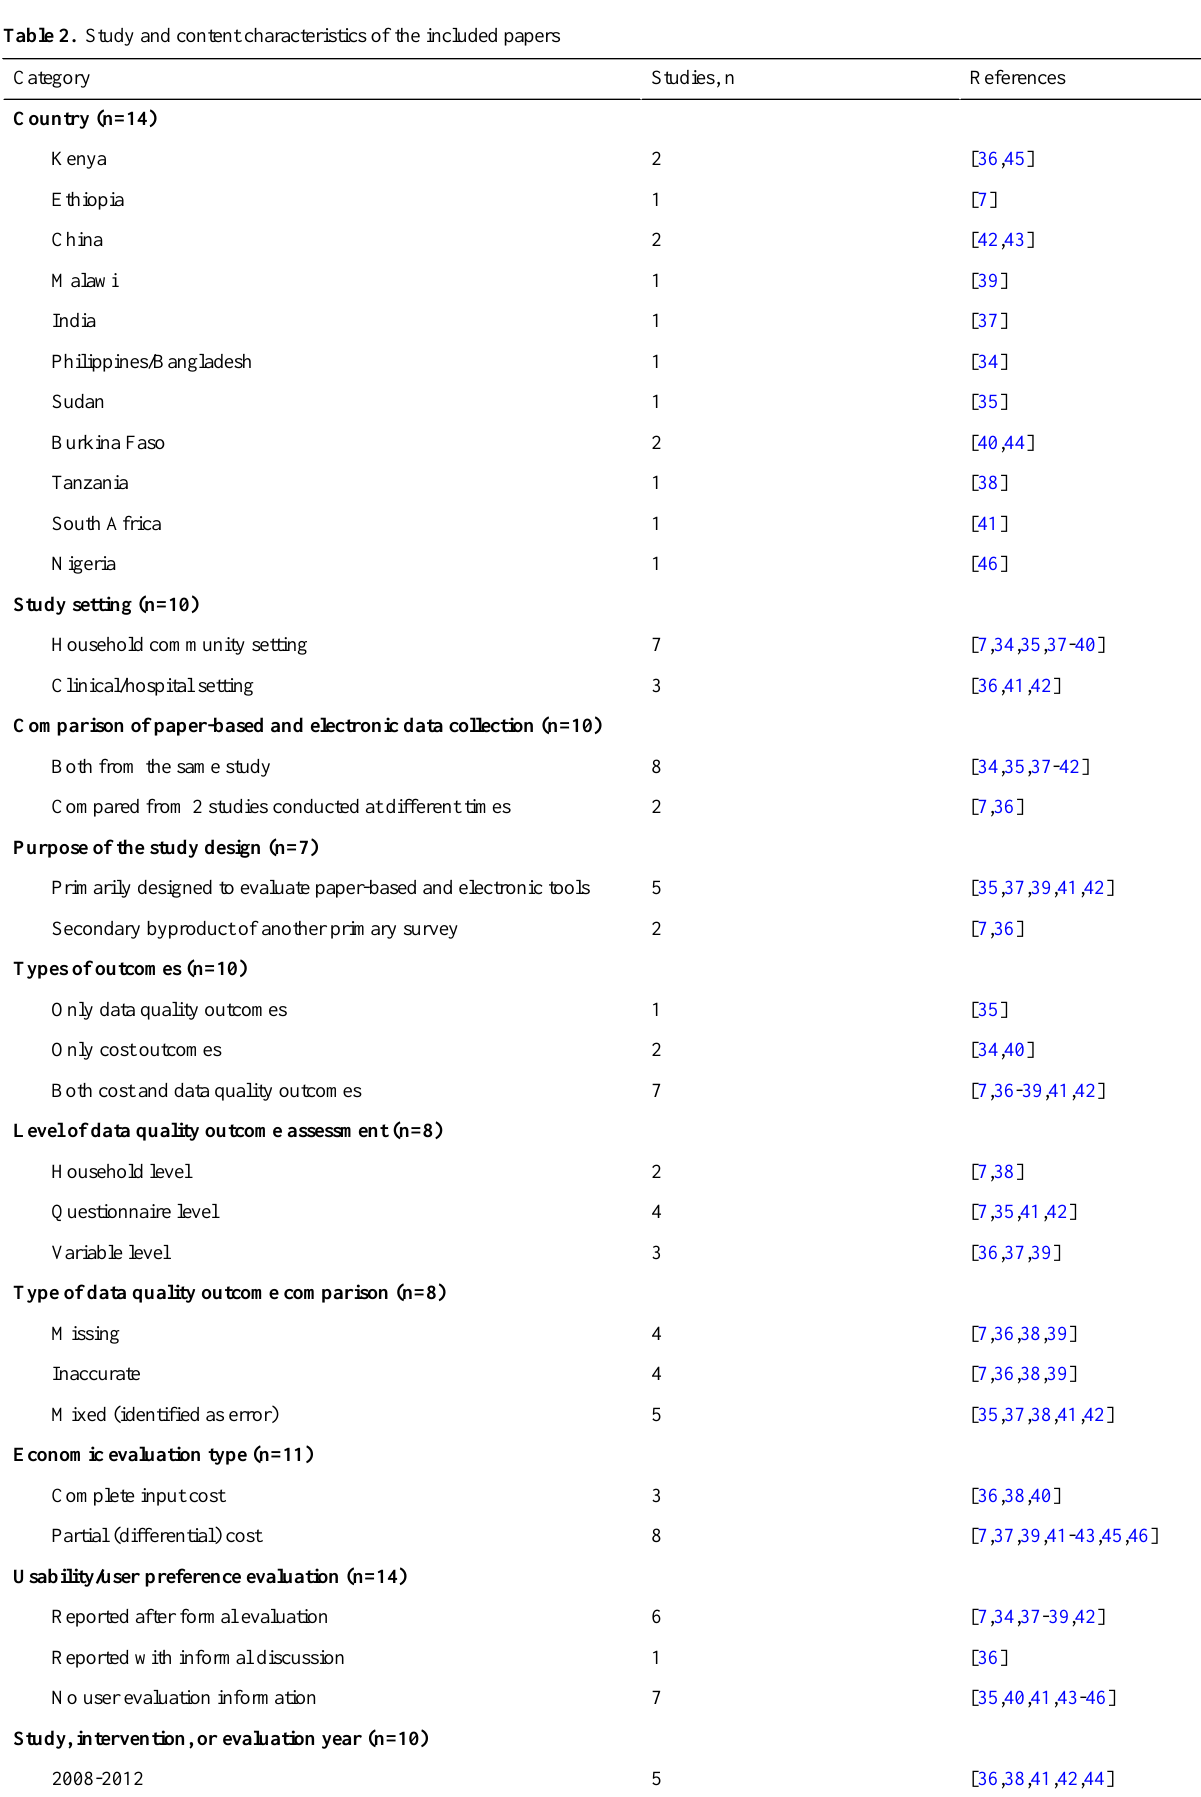
Table 2. Study and content characteristics of the included